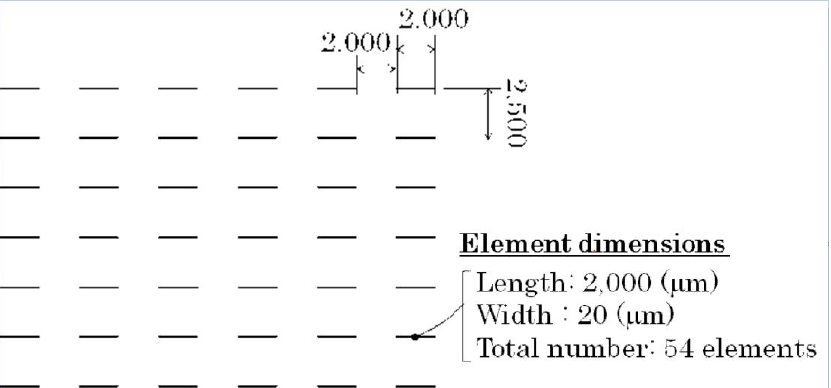
Figure 2. Direction of easy axis θ and an enlarged picture of the fabricated element.